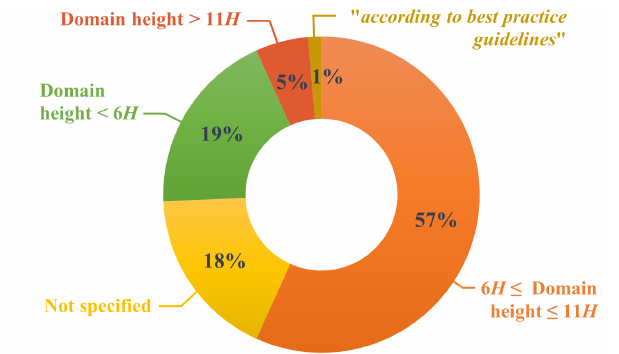
Figure 8. Domain height